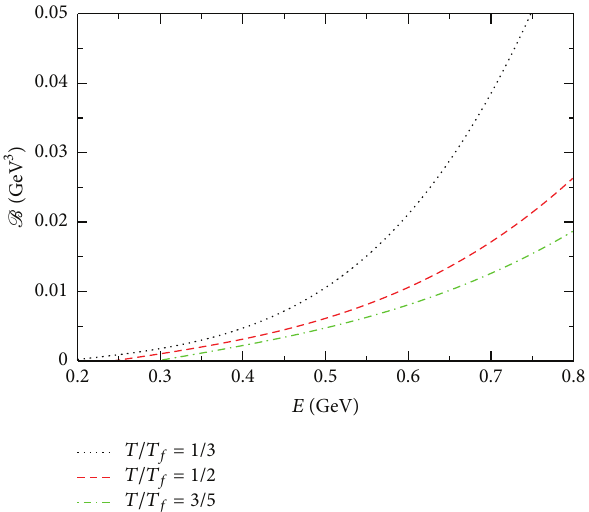
= 1/2 (dashed curve), and 𝑇/𝑇 𝑓